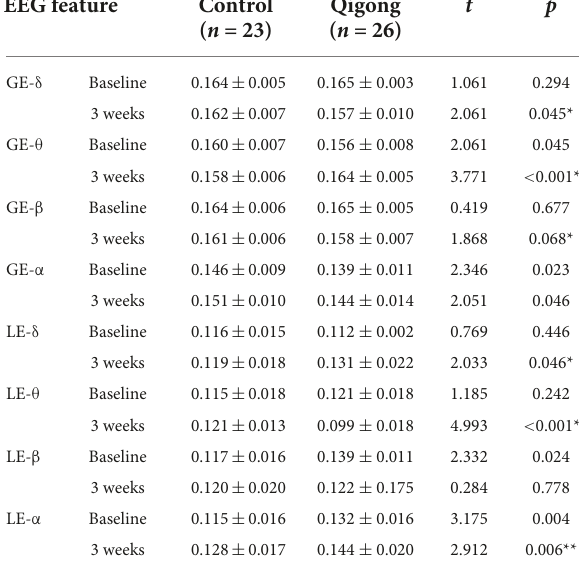
TABLE 4 Areas under the curve (AUC) of global efficiency (GE) and local efficiency (LE) associated with different sparsity levels in the electroencephalography (EEG)